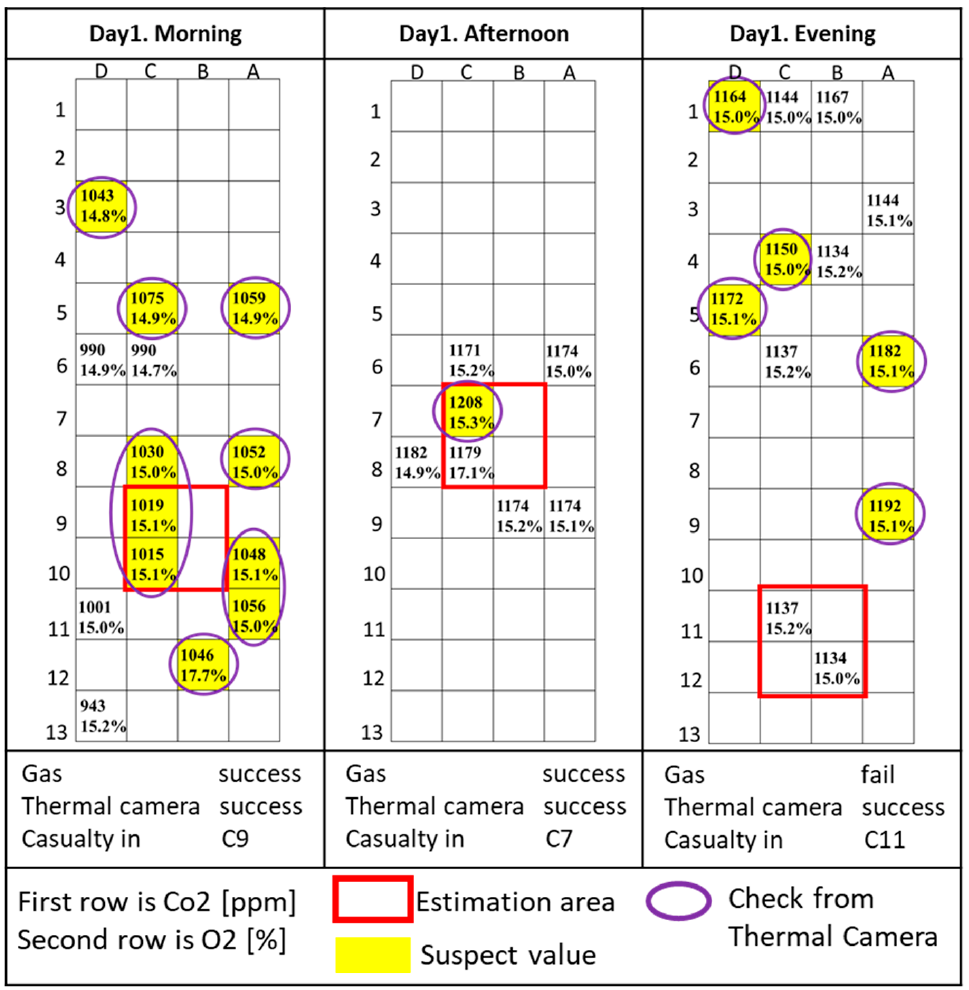
Figure 4. Day 1 results.